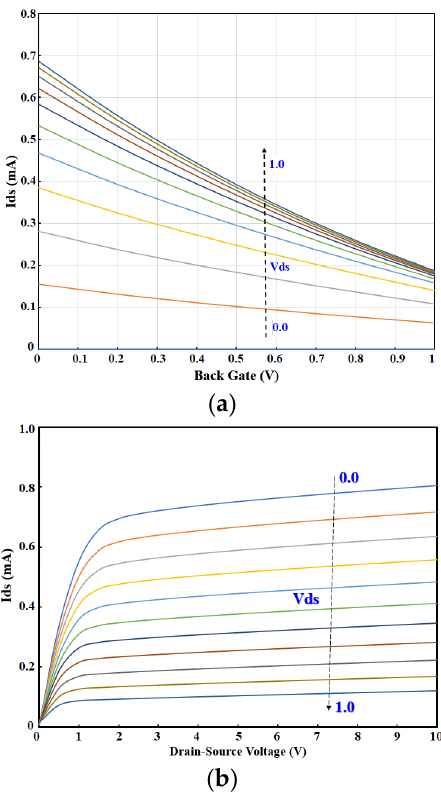
Figure 7. Transfer characteristics of OG-JFET sensor derived from COMSOL simulations. ( a ) Reverse- bias Ids-Vgs. ( b ) Reversed-bias